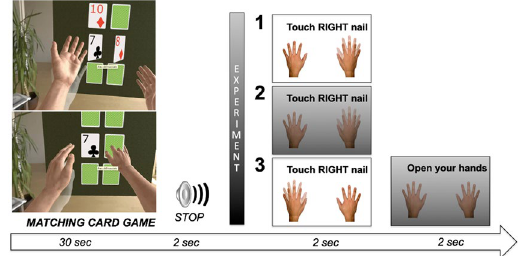
Figure 5. Depiction of a single trial. The matching card game, the stop signal and the end of the trial were common to all the experiments, but the presentation of the instructions and the following reaching task varied. In Experiment 1, instructions were displayed above the visible VR hands and the reaching was performed towards the displaced hand; in Experiment 2, instructions were displayed above a black screen and the vision of the hands was eliminated during the reaching. In Experiment 3, instructions were displayed above the visible VR hands and reaching was executed with the displaced hand. In all examples below, the VR hand is represented with a natural color, while the semi-transparent hand represents the position of the real hand that was not visible to the participants during the